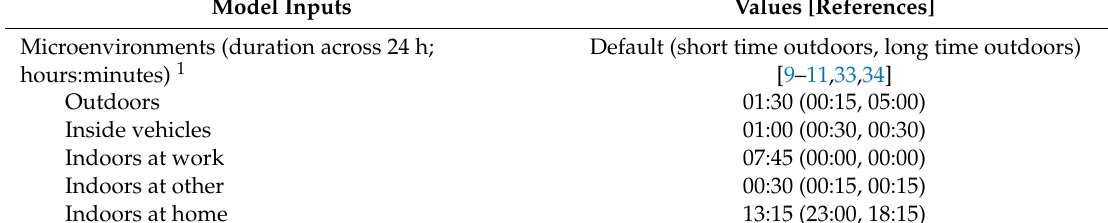
Table 4. Sensitivity analysis: inputs for microenvironments, physical activities, and demographics. Model